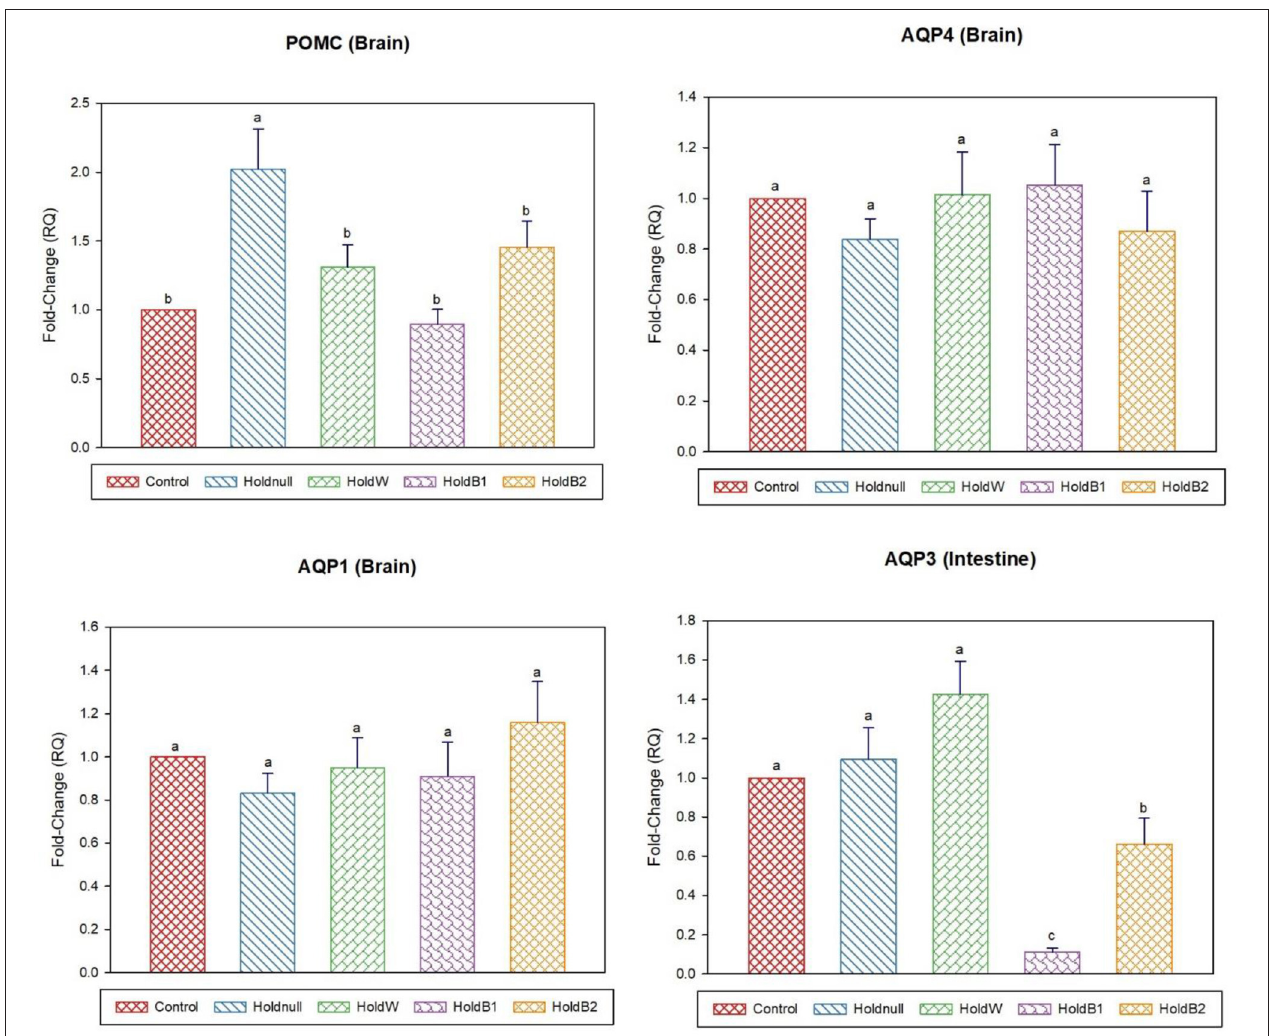
FIGURE 3 | Effect of betaine on the relative expression (fold-change or RQ) of POMC, AQP4, AQP1 in the brain, and AQP3 in the intestine of day-5 old chicks. Control, placed on feed immediately; Holdnull, holding for 48h + no access to feed or water; HoldW, holding for 48h + water only; HoldB1, holding for 48h + water supplemented with betaine (1ml per L); HoldB2, holding for 48h + water supplemented with betaine (2ml per L). Bars with different letters are significantly different ( p < 0.05). Mean ± standard error of the mean, n = 6. AQP, aquaporin; POMC,